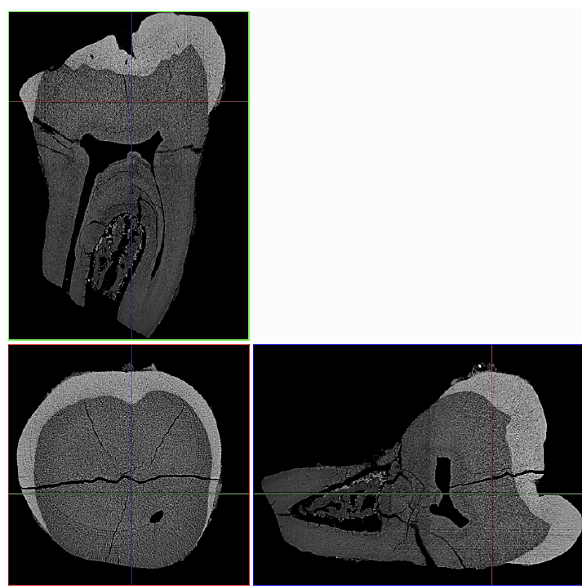
Figure 8. Separated parts of the